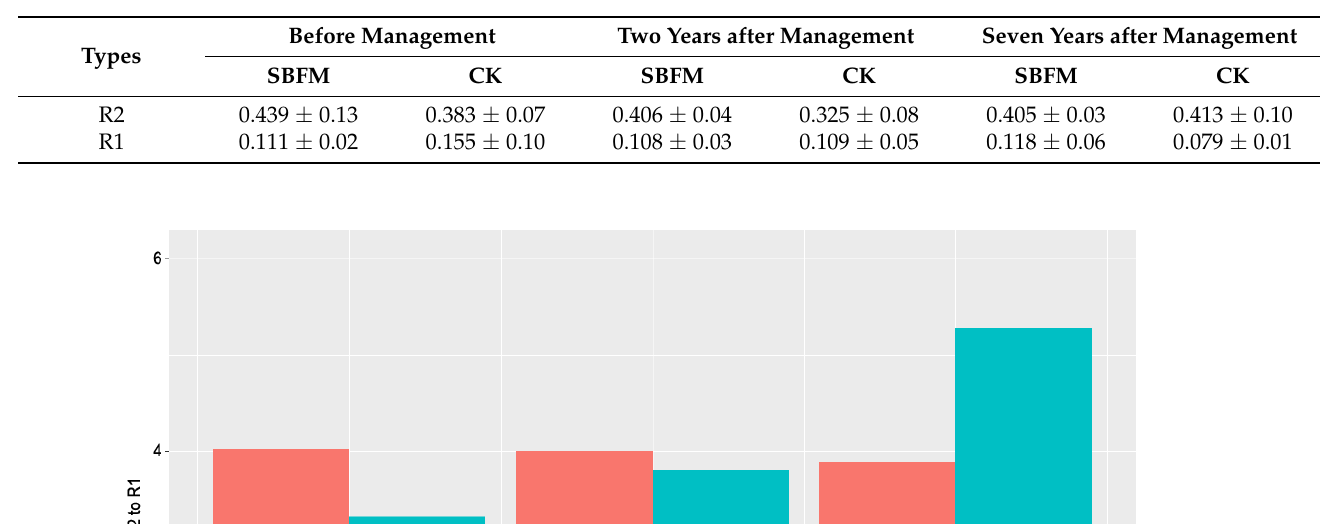
Table 3. The average frequency of R2 and R1 in total plots.